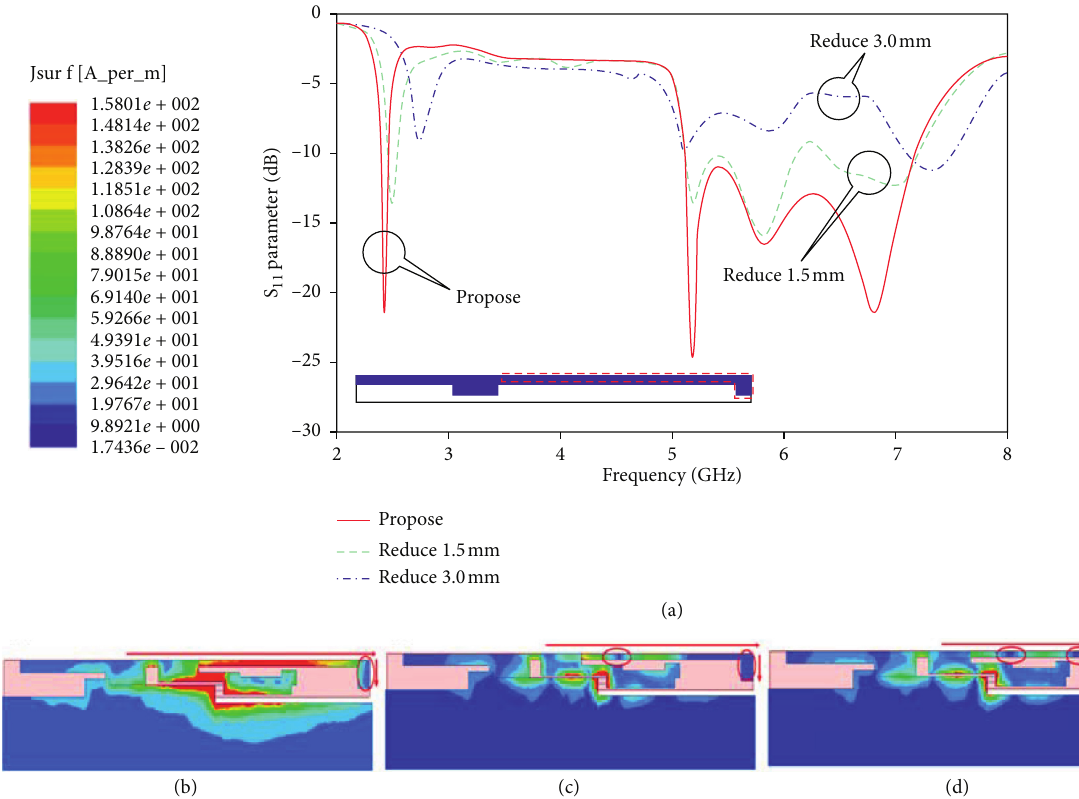
Figure 5: (a) Simulated S 11 with different lengths of couple-fed right arm of the antenna. Current distribution of couple-fed right arm at (b) 2.45, (c) 5.825, and (d) 6.85GHz.